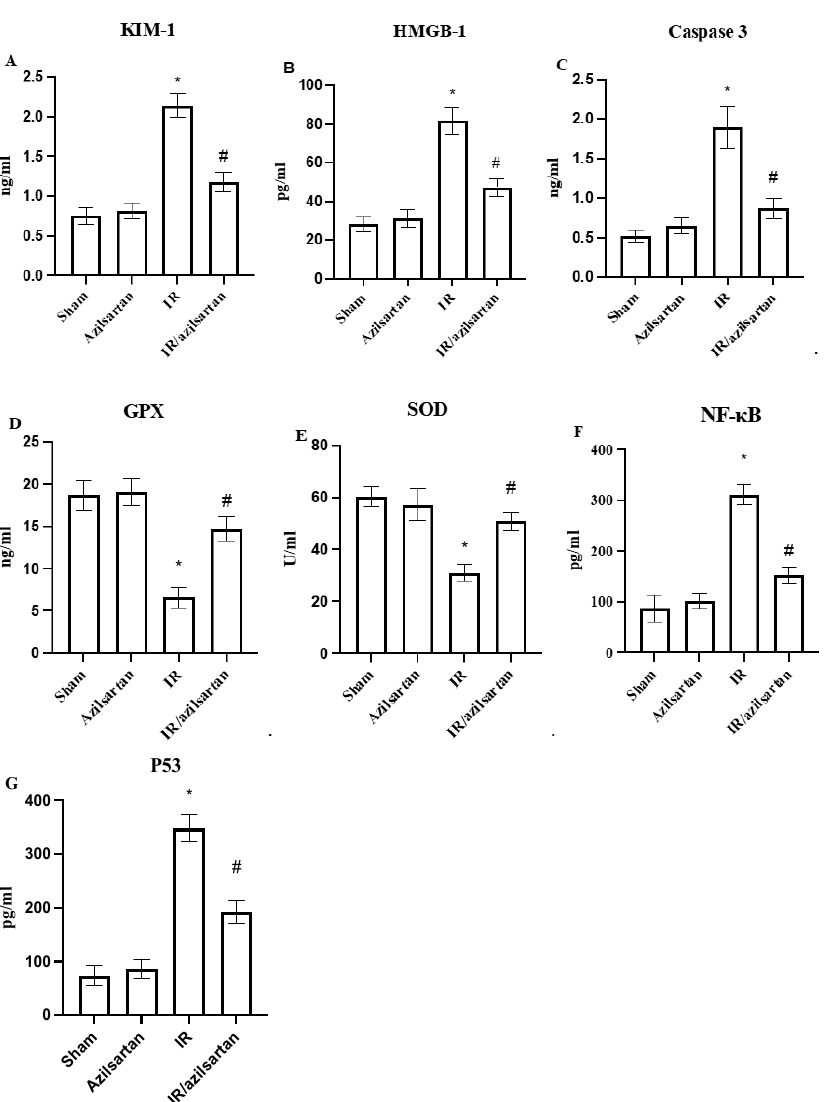
Figure 1. Creatinine ( A ) and BUN ( B ) serum levels. Bars represent mean ± SD. Followed by post hoc Dunnett test, significant difference was analyzed by one-way ANOVA test, where * p < 0.001, compared to the sham group, and # p < 0.001, compared to the IR group. BUN; blood urea nitrogen, SD; standard deviation, IR; ischemia reperfusion.